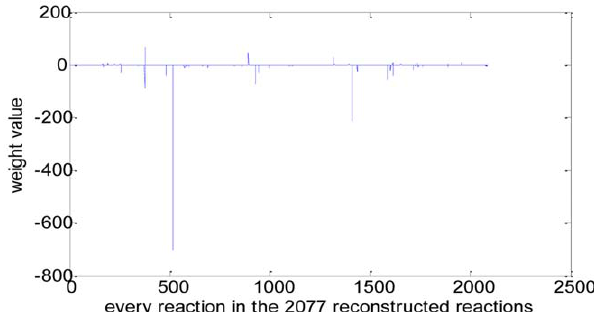
consistent consistent Note: Row A – Number in E. coli _iAF1260; Row B – Our computation result comparing with Ref. [5]. Figure 2. Weight value distribution of the metabolic network of E.coli _iAF1260. X -axis indicates every reaction in the reconstructed D f G ; . reactions (the order is as the same as in rxns , total 2077) and y -axis Column C – reactions with known D r G but not involving compounds with indicates the value of its corresponding weight. rxns is the reaction set in the model.